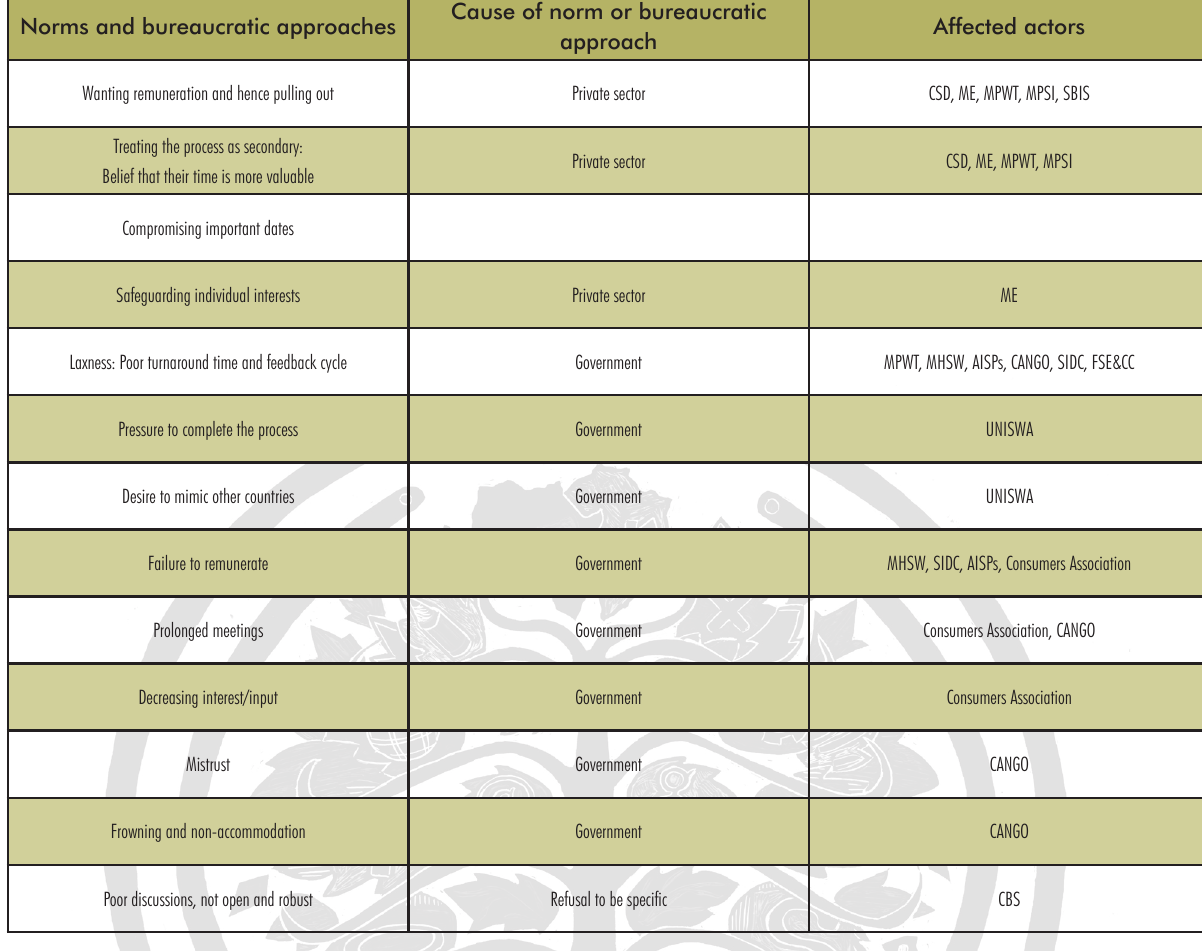
Cause of norm or bureaucratic Affected approach